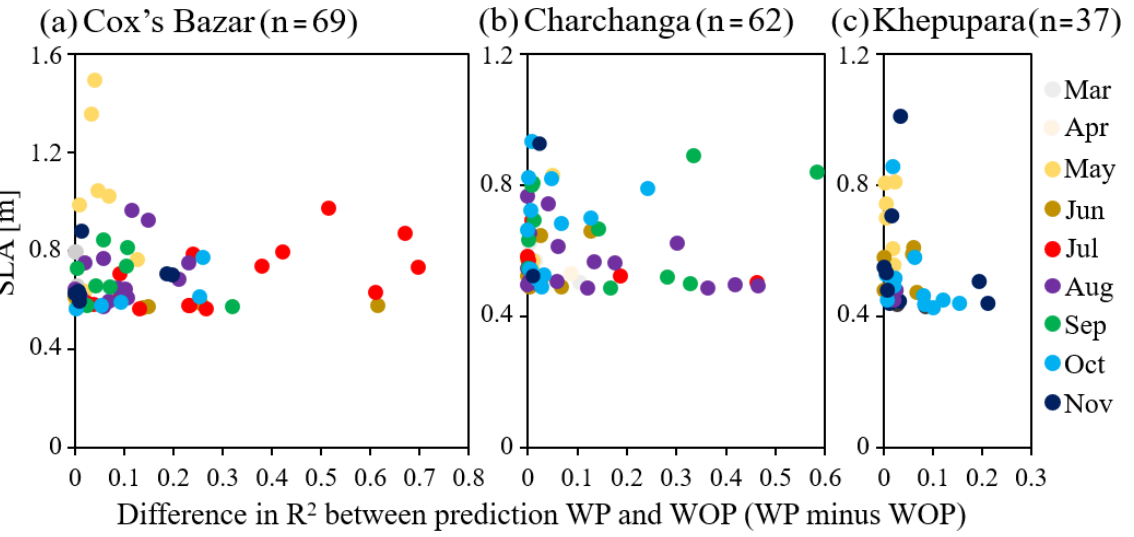
Figure 10. Monthly variations in the R 2 difference between predictions WP and WOP at ( a ) Cox’s Bazar, ( b ) Charchanga, and ( c ) Khepupara. Dots represent extreme sea level events, and the colors indicate the months when they occurred.